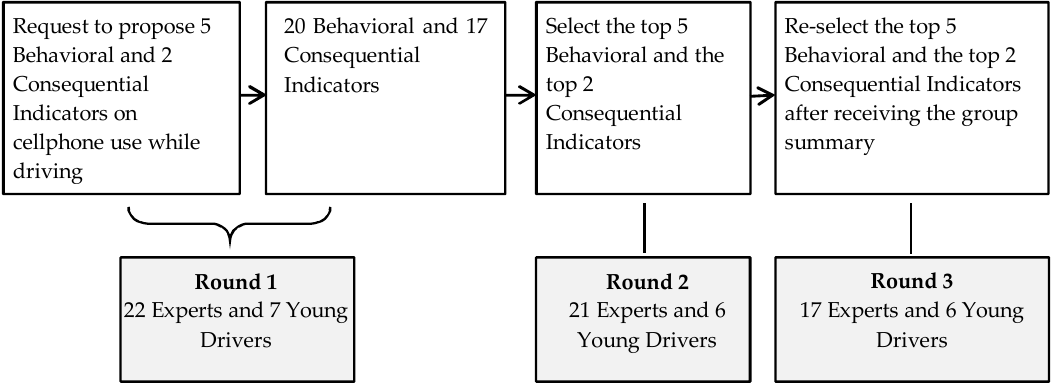
Figure 1. Flow chart: a Delphi Survey on behavioral and consequential indicators of cellphone use while driving, United States, 2016.